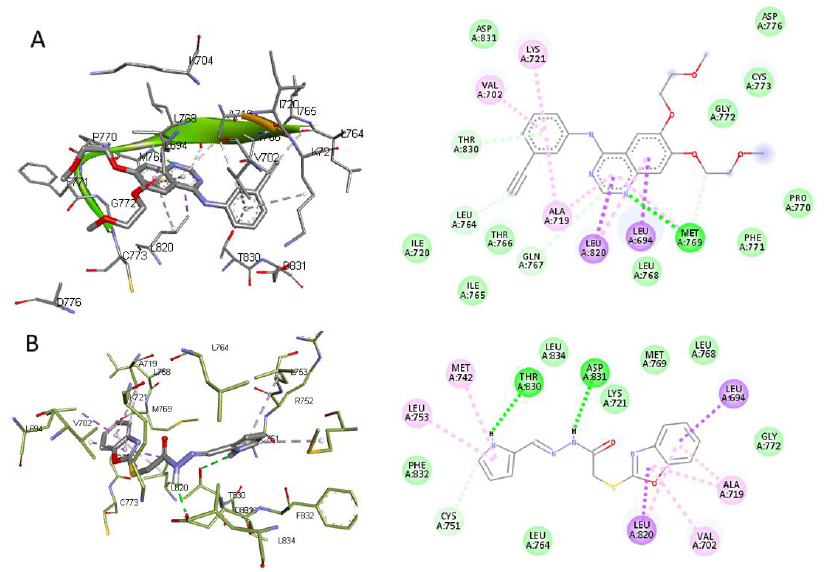
Figure 2. Schematic 2D and 3D depictions of the molecular simulation of erlotinib ( A ) and compound 6b ( B ) within the ATP-binding site of EGFR (PDB ID: 4HJO). Green dotted lines represent hydrogen bonding.